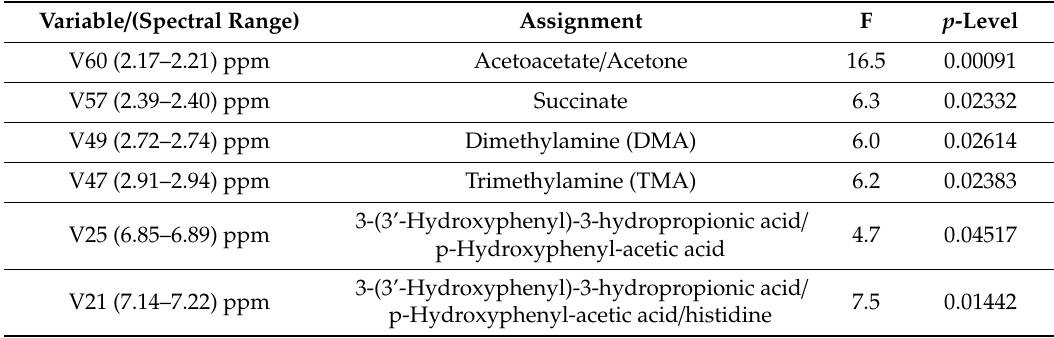
Table 3. ANOVA results on 75 variables to di ff erentiate urinary samples after meals with and without blueberries. Significant variables ( p -level < 0.05) together with the corresponding assignment are